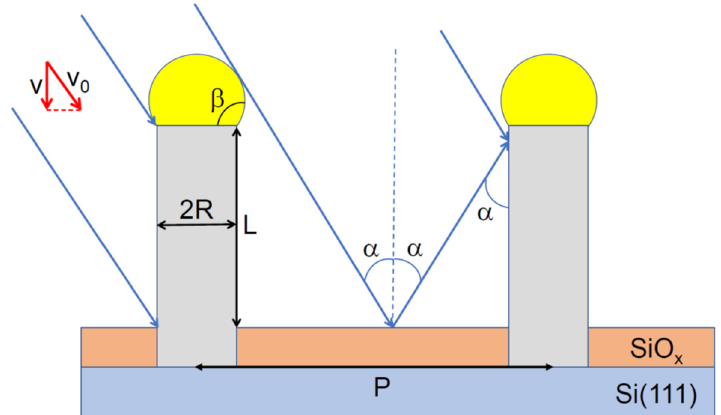
Figure 1. Illustration of NW growth by selective area VLS-MBE on a reflecting substrate in the case of specular reflection, where group III atoms simply bounce off the silica mask. P denotes the pitch of the NW array. NWs are considered cylinders with length L above the mask surface and uniform radius R . The reflected flux impinges the NW side facets at the same angle α as the primary flux. The total current into the NW, F = F dir + F ref , contains contributions from the direct ( F dir ) and reflected ( F ref ) fluxes. The maximum current is given by F max = vP 2 , as discussed above. The direct current is given by F dir = vS if S / P 2 < 1 and vP 2 if S / P 2 ≥ 1, where S is the NW surface area (including the nanoparticle surface area for metal-catalyzed NWs or NW top facet for catalyst-free SAE NWs) exposed to the direct flux. The expression F dir = vS is the common definition of the direct material flux onto the NW [10,18,27,28]. It shows that the volume of group III atoms impinging the NW per unit time equals the group III flux times the total surface area of this NW exposed to the flux. However, this expression does not account for the shadowing effect. When S becomes larger than P 2 , the direct flux can no longer increase. Instead, it stabilizes at the maximum value vP 2 , meaning that each NW in the array of N NWs per unit surface area receives a part of the total flux vP 2 = v / N